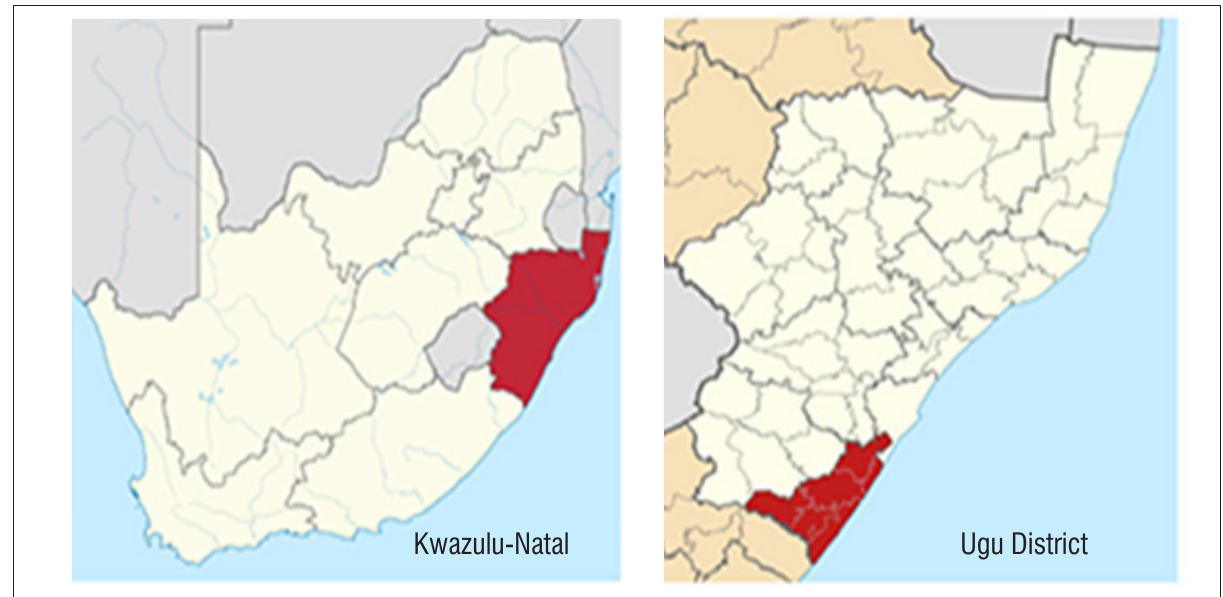
Figure 1: Map showing KwaZulu-Natal Province and Ugu District within KwaZulu-Natal, South